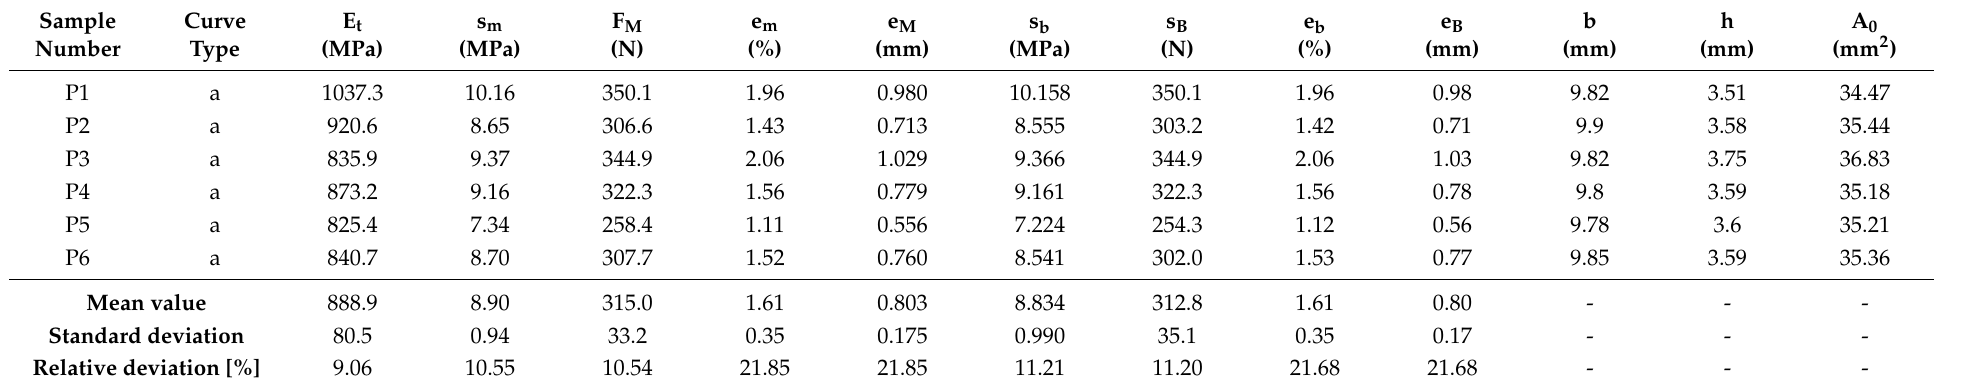
Table A40. Results of the tensile tests of PO_A,C.